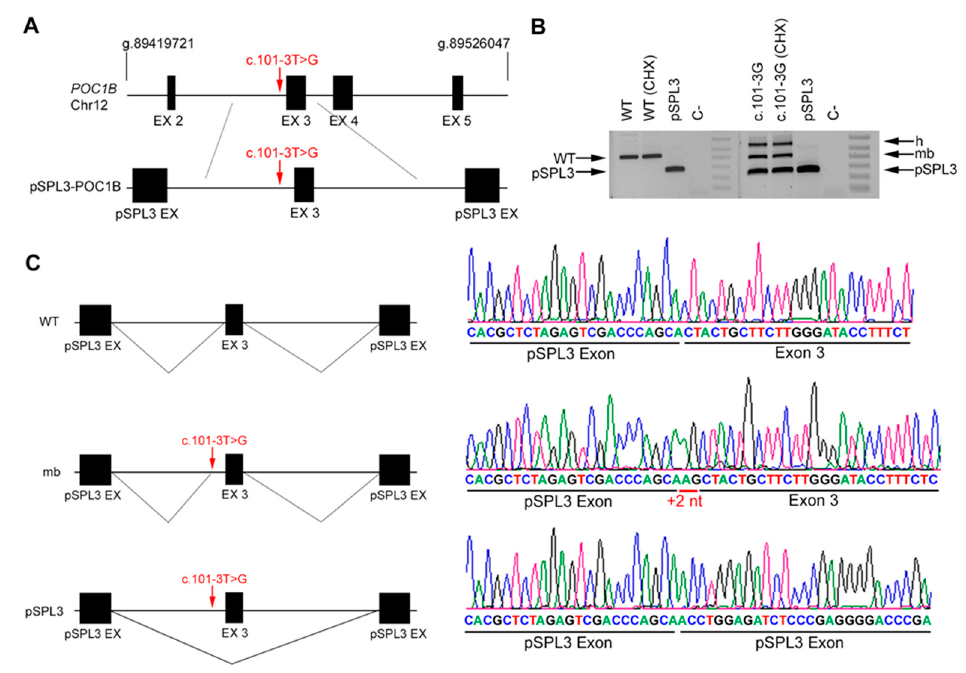
Figure 5. In vitro splicing analysis of the non-canonical splice site (NCSS) variant identified in POC1B . ( A ) Genomic position of the NCSS variant in intron 2 of the POC1B gene (c.101-3T > G) from patient DBG4. Diagram showing the genomic region between introns 2 and 3 amplified from patient’s DNA, cloned into the pSPL3 vector. ( B ) Analysis of POC1B mRNAs from HEK293T cells transfected with either empty vector, WT or mutant genomic sequences (treated or untreated with cycloheximide, CHX). The band of 429 bp corresponds to the wild-type transcript (WT), whereas cells transfected with pSPL3 carrying the NCSS variant produced one aberrant transcript (mb) plus the same transcript band produced by the pSPL3 control vector, indicating an exon skipping event. h indicates the heteroduplex band of the mb and skipped transcript products. C- indicates the PCR negative control. ( C ) Subsequent Sanger sequencing of cloned individual bands, indicated in the left diagrams, confirmed the insertion of + 2 nt (mb) and the skipping of exon 2 compared to the wild-type transcript.